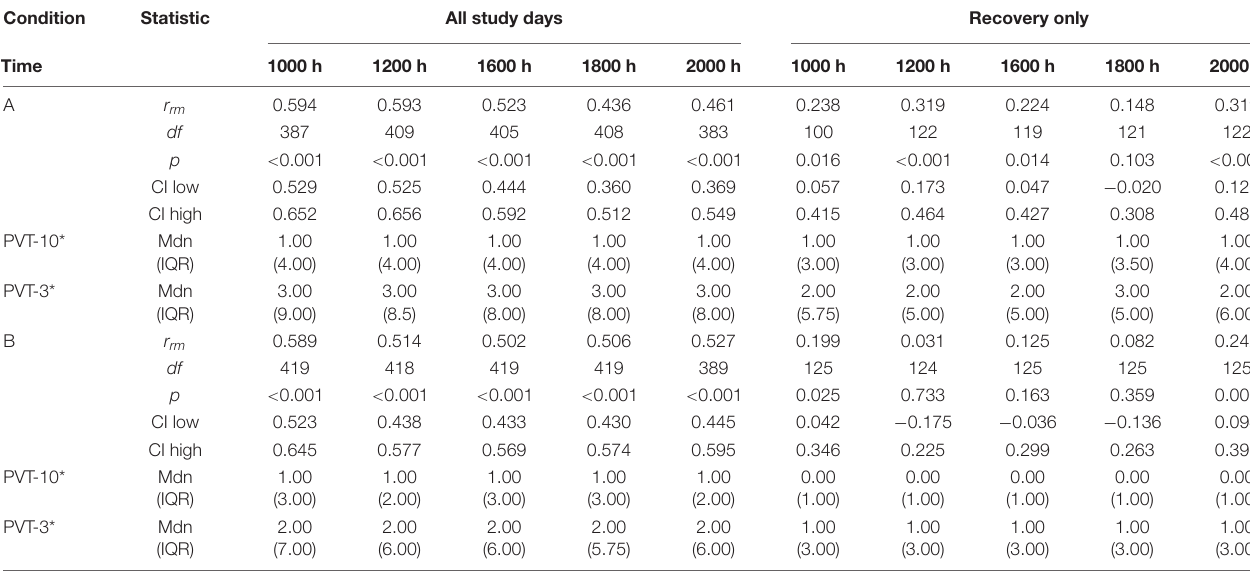
TABLE 2 | PVT-10 and PVT-3 transformed lapses rmcorr results by time point.